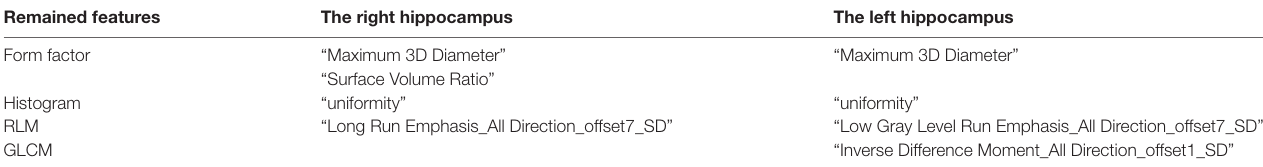
TABLE 2 | The remaining features after three steps of feature